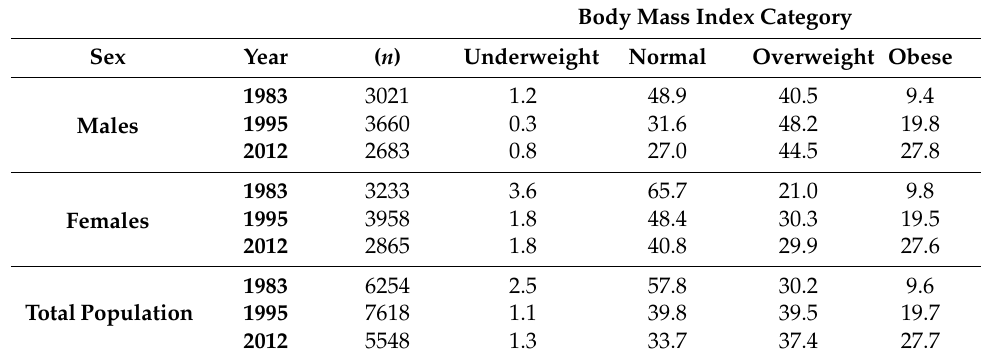
Table 1. Prevalence of overweight and obesity of Australian men and women aged 25–64 years in national nutrition surveys from 1983, 1995 and